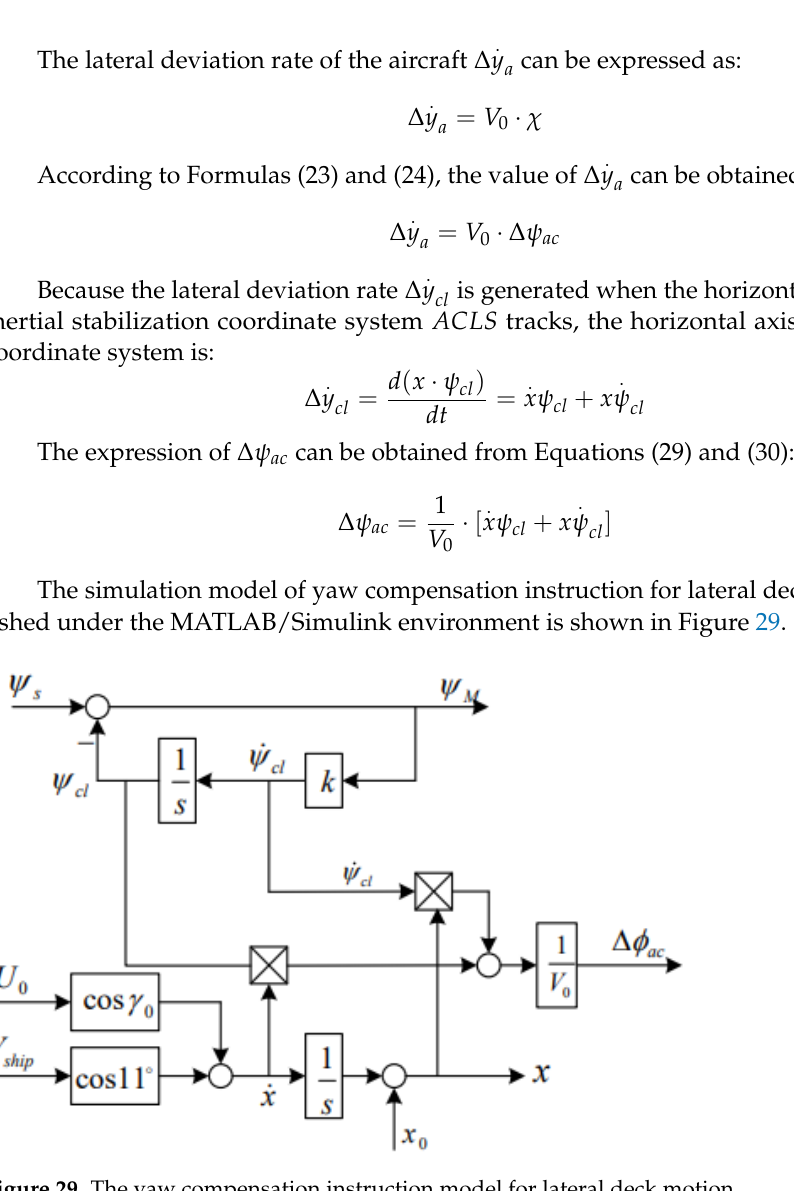
Figure 29. The yaw compensation instruction model for lateral deck motion.